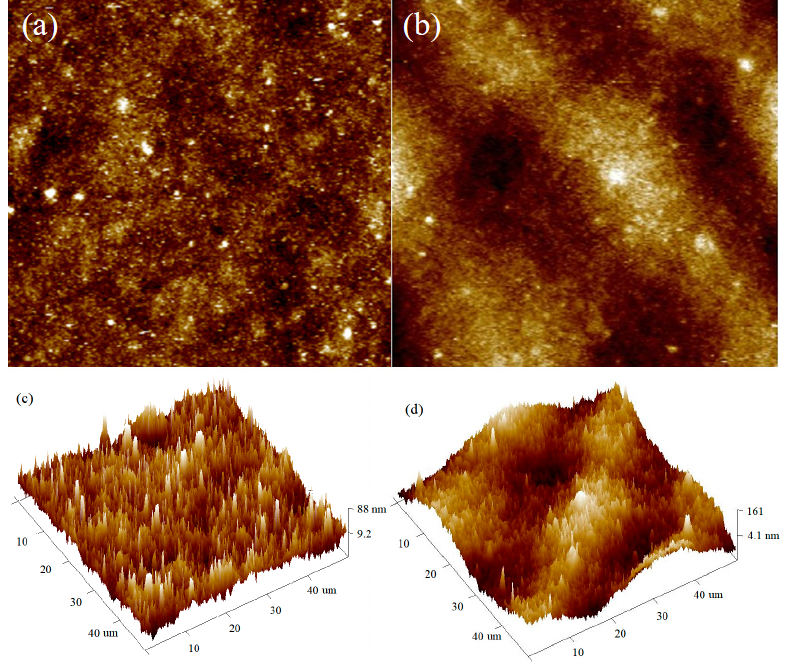
Figure 8. AFM of TiO 2 thin film on different electrode surfaces: ( a ) TiO 2 film morphology on FTO; ( b ) TiO 2 film morphology on stainless steel; ( c ) AFM 3D diagram on FTO; ( d ) AFM 3D diagram on stainless steel.